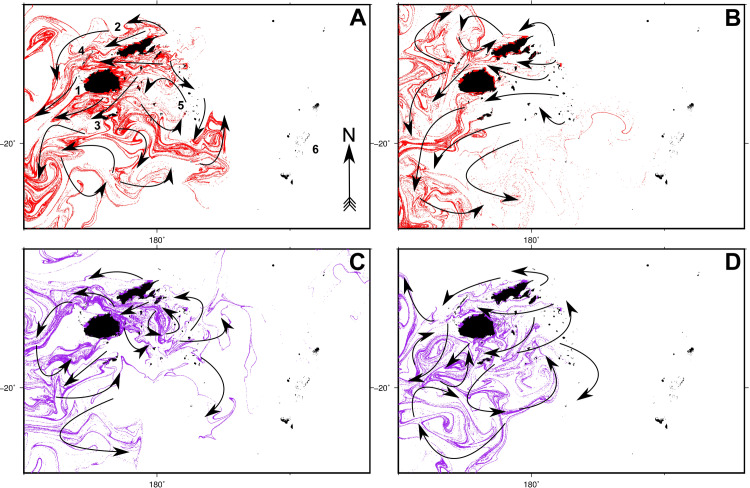
Particle dispersal simulation results for 2014 and 2015 datasets (ENSO years).Final (day 60) particle position plots are shown for spawning seasons 1 (A) and 2 (B) for 2014, and seasons 1 (C) and 2 (D) for 2015. All simulations were run for 60 days. Arrows denote the positions and trajectories of major particle flux patterns. Animations of these simulations are available as S5–S8 Gifs. Numbers denote the following localities: Viti Levu (1), Vanua Levu (2), Kadavu (3), Yasawa archipelago (4), Lau archipelago (5) and the Kingdom of Tonga (6).